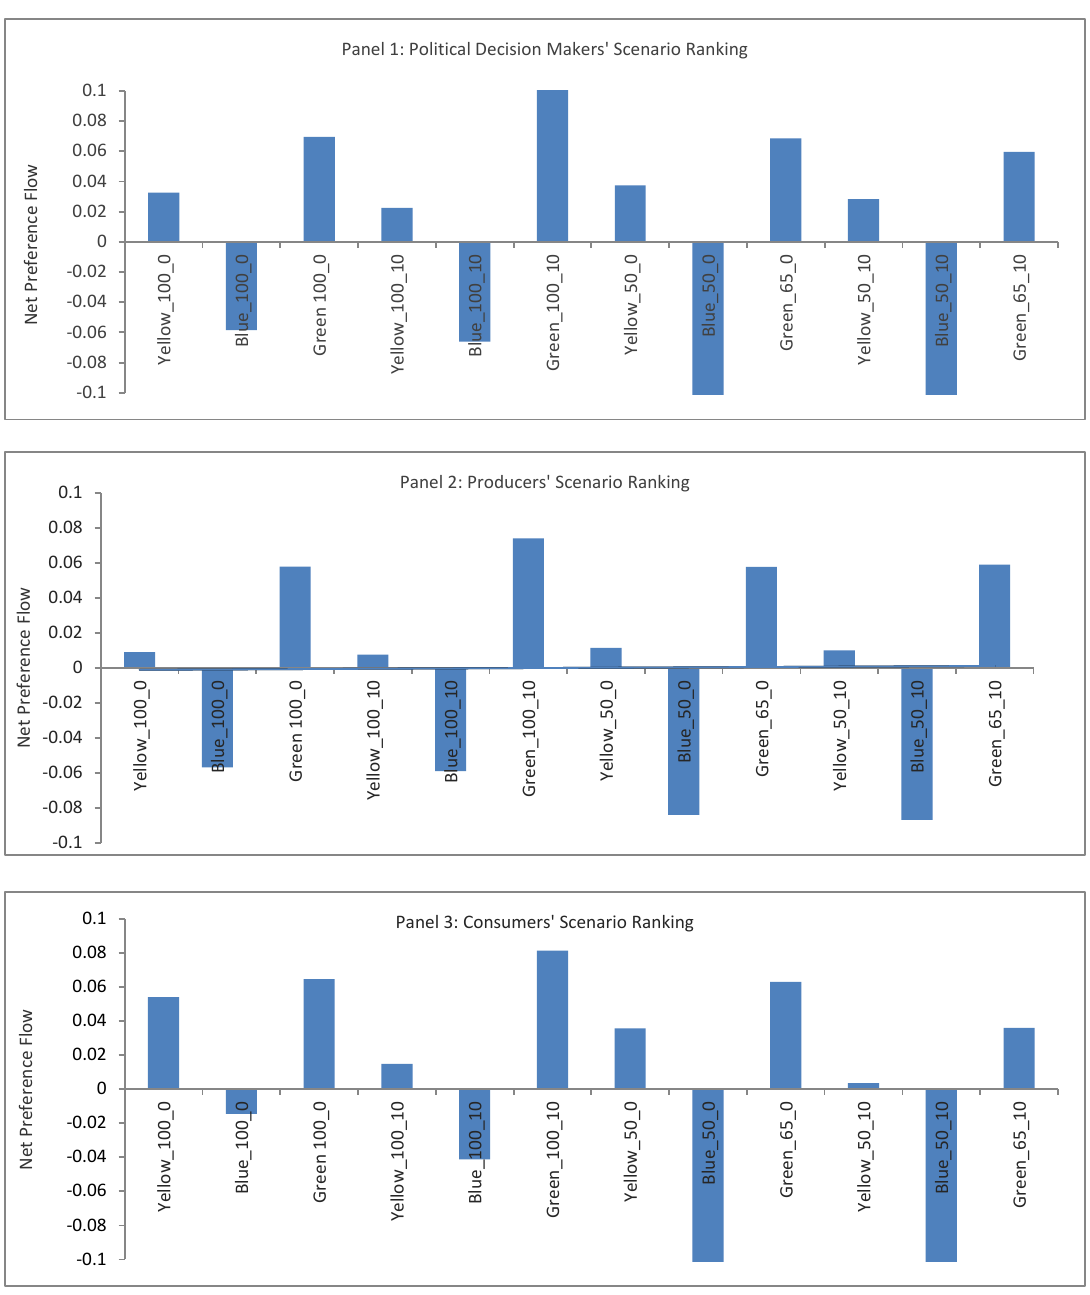
Figure A2. Scenario ranking for: ( i ) political decision makers (Panel 1), ( ii ) producers (Panel 2) and ( iii ) consumers (Panel 3).